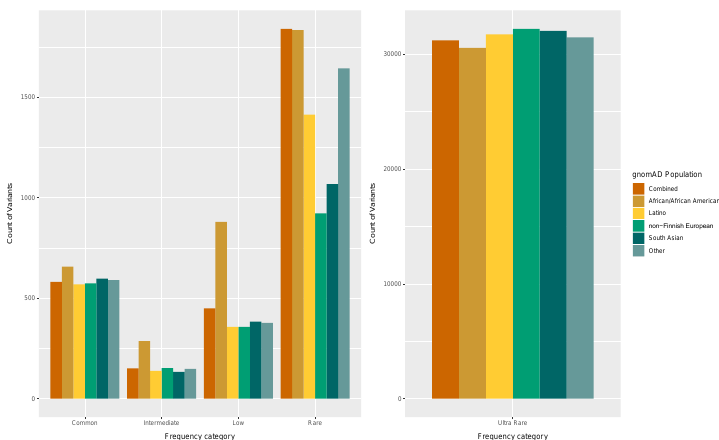
Figure 4. Variant counts in PGx genes, as identified in the DiscovEHR cohort, within various gnomAD populations. Variants were classified in the following categories: common (MAF >= 0.10 or MAF >= 10%), intermediate (0.05 =< MAF < 0.10 or 5% =< MAF < 10%), low frequency (0.01 =< MAF < 0.05 or 1% =< MAF < 5%), rare (0.001 <= MAF < 0.01 or 0.1% =< MAF < 1%), ultra-rare (MAF < 0.001 or MAF < 0.1%). Abbreviations: MAF, minor allele frequency; PGx, pharmacogenomics.